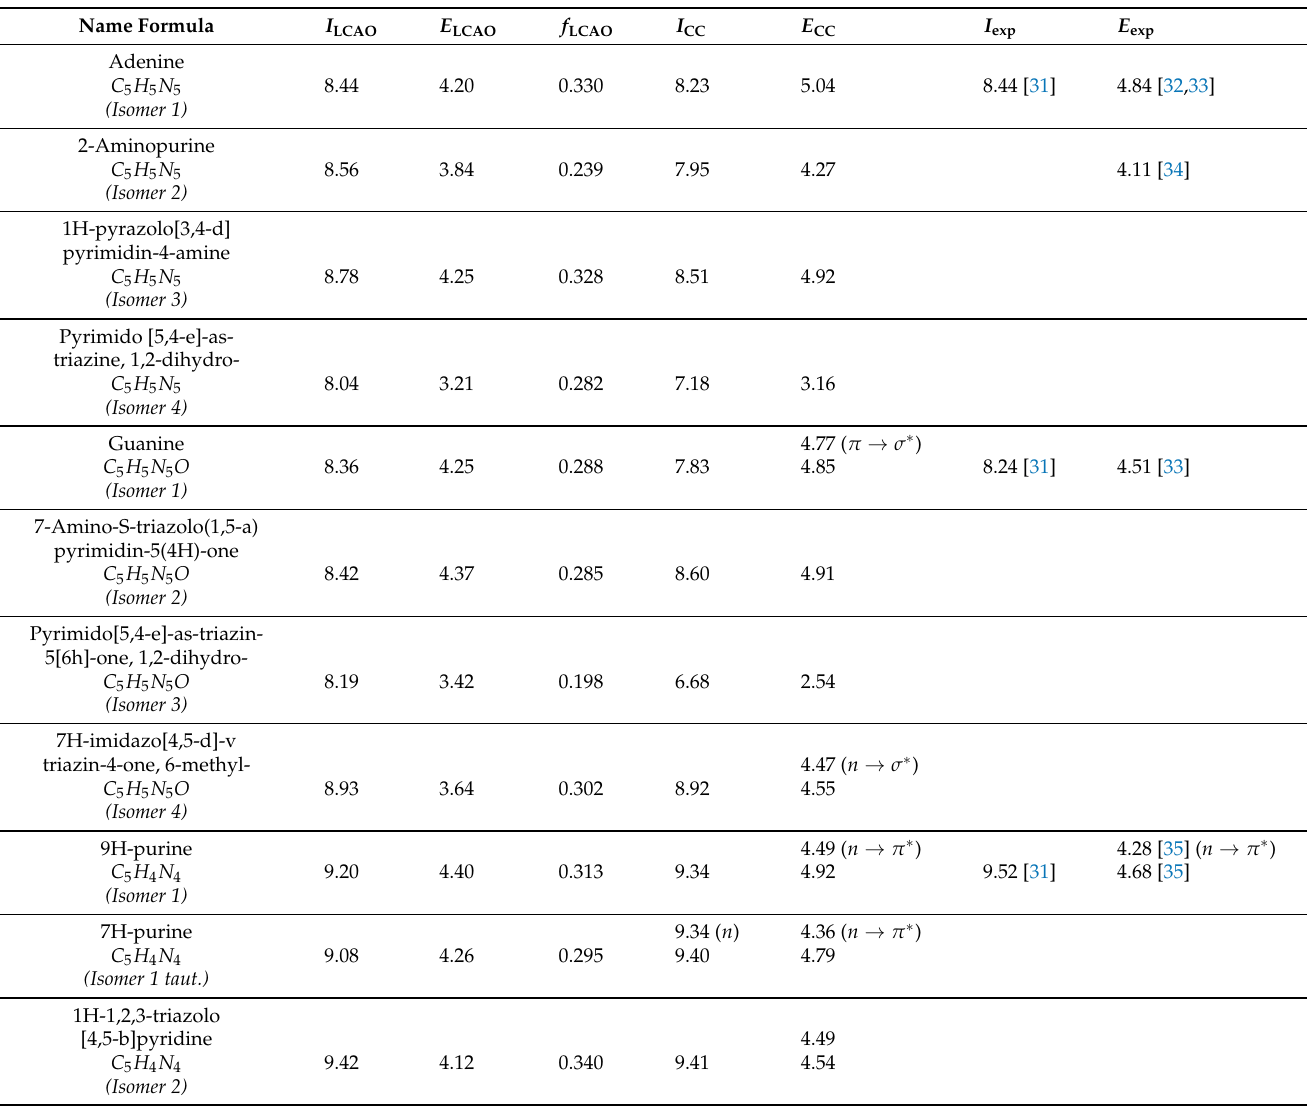
Table 4. Ionization and excitation energies (eV). I LCAO and E LCAO are the ionization and excitation energies obtained by our LCAO scheme, including all valence orbitals. f LCAO is the relevant oscillator strength. I CC and E CC are the energies calculated at the IP-EOMCCSD/aug-cc-pVDZ and CR-EOMCCSD(T)/aug-cc-pVDZ level of theory [29]. I exp and E exp are the experimental data. In parentheses, the character of the